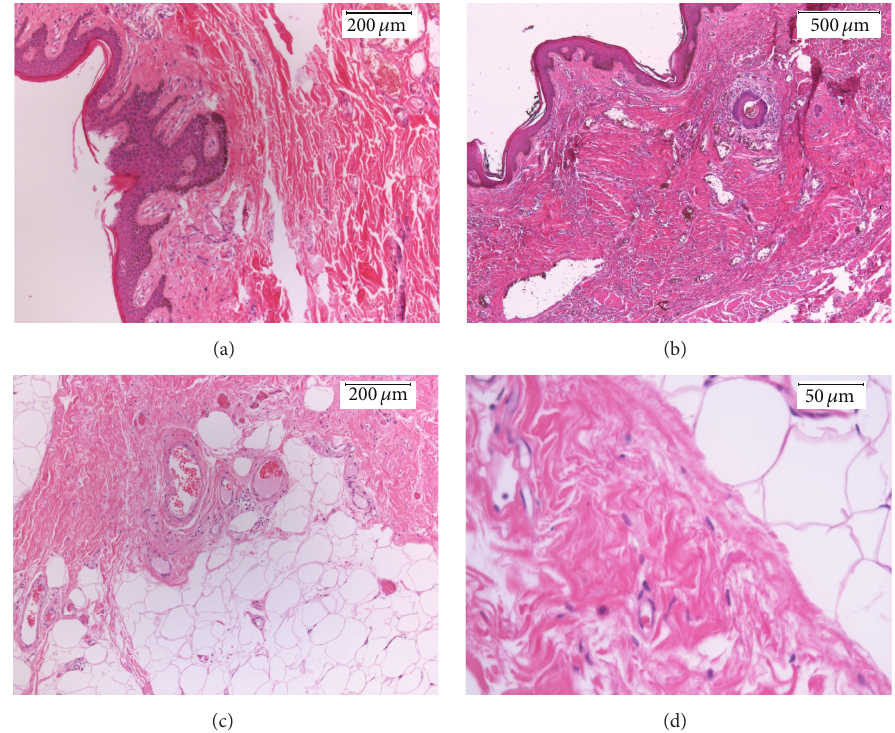
Figure 2: Histomorphology of MLL. The epidermis showed mild acanthosis, elongated rete ridges, basal melanocytic proliferation, and hyperpigmentation ((a), 20x). The dermis revealed reactive lobular vascular proliferation with congestion and mild lymphocytic infiltration similar to stasis dermatitis ((b), 10x). The subcutaneous areas show adipose tissue and reactive vascular proliferation ((c), 20x) and reactive fibroblasts ((d),